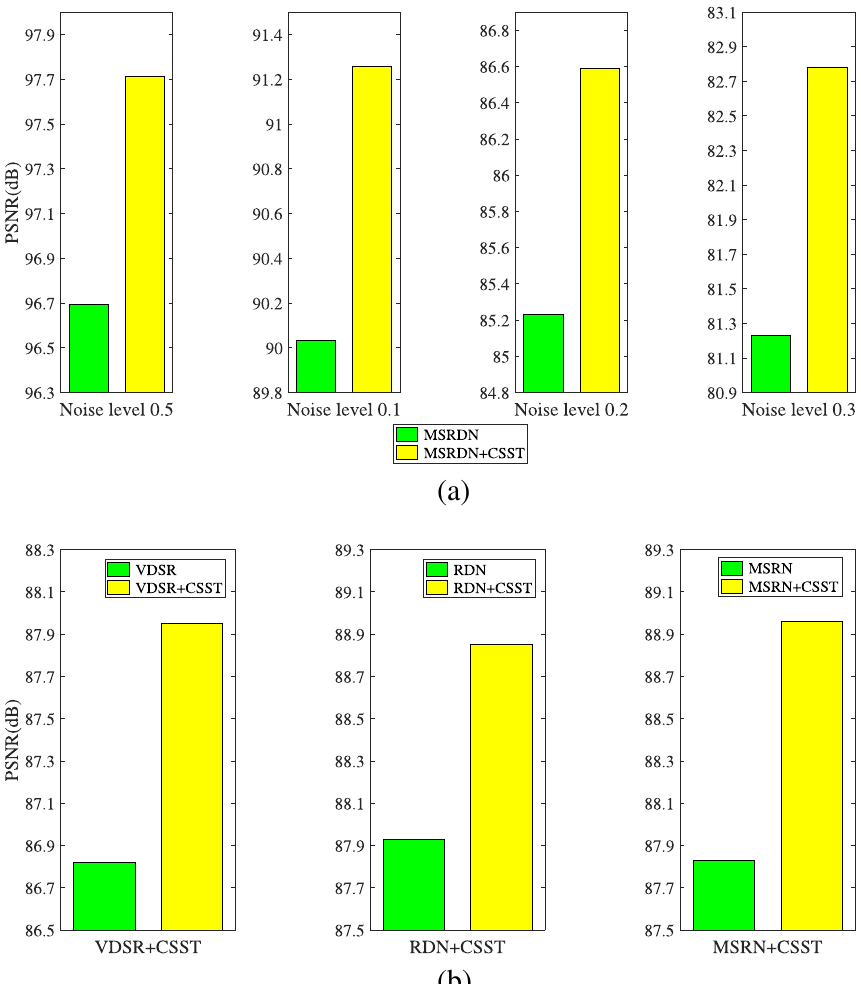
Fig. 9 Effectiveness of CSST predictions. a PSNRs for spatial and CSST domains. b PSNRs for CSST predictions with various